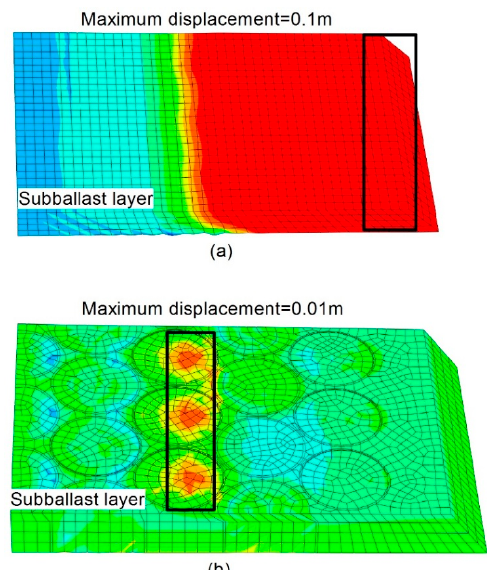
Figure 11. FEM modelling for rubber tire-reinforced capping layer: ( a ) Track geometry with rubber tires reinforced capping layer; ( b ) FEM mesh of ballasted railway track; ( c ) FEM mesh of rubber tires (modified after Indraratna et al. [8]).